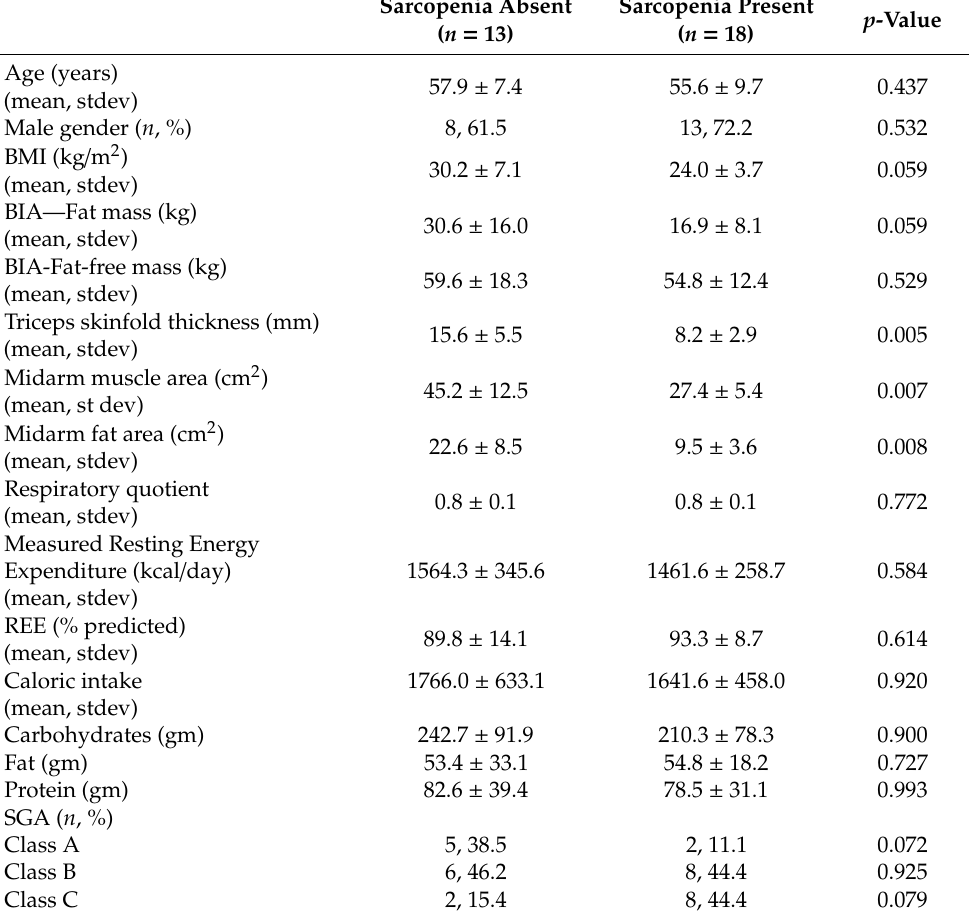
Table 1. Patient demographic and metabolic characteristics by sarcopenia